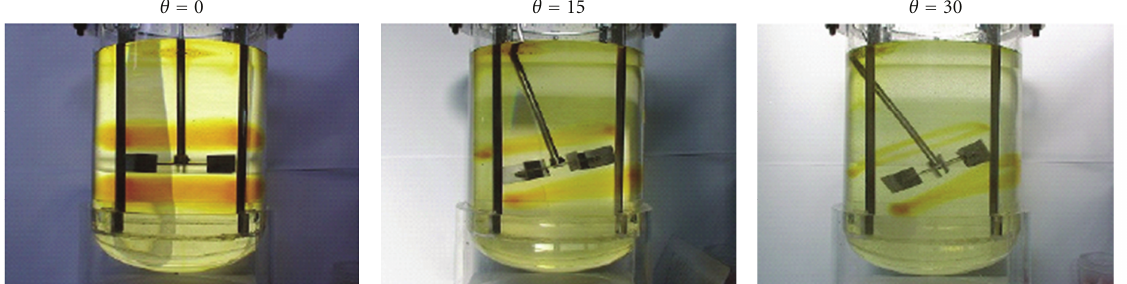
Figure 2: Isolated mixing regions observed (50min − 1 , DT), Re =